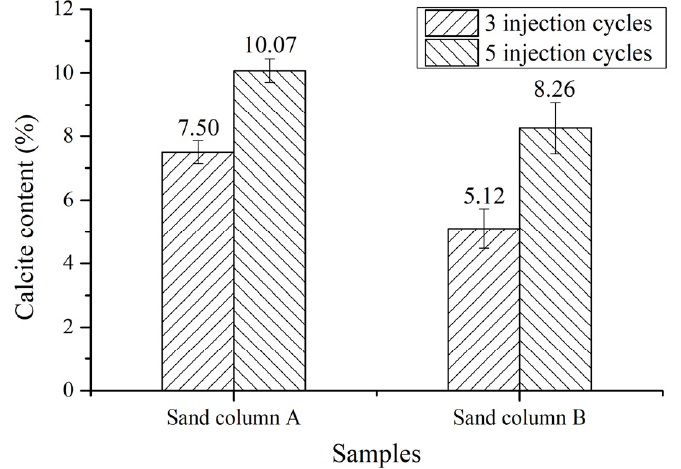
Figure 3. Calcium carbonate content of each sand column.